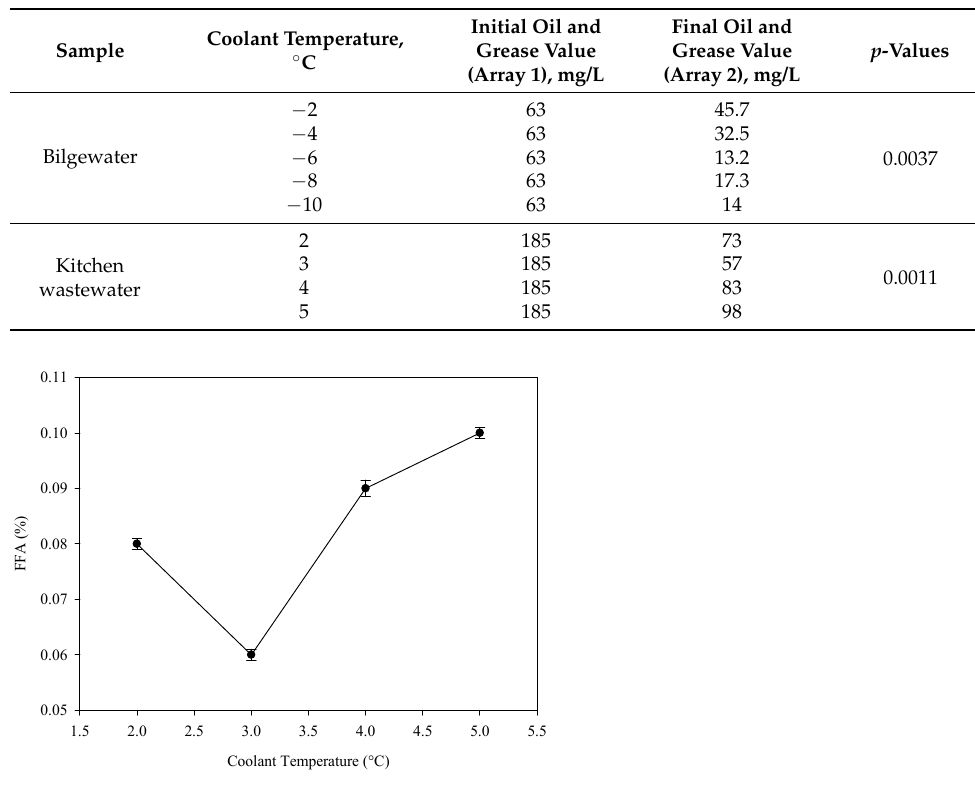
Figure 2. Changes of oil and grease removal/recovery for oily bilgewater and kitchen wastewater samples at different coolant temperature (°C). Table 3. Initial and final oil and grease values at different coolant temperature and p -values obtained.